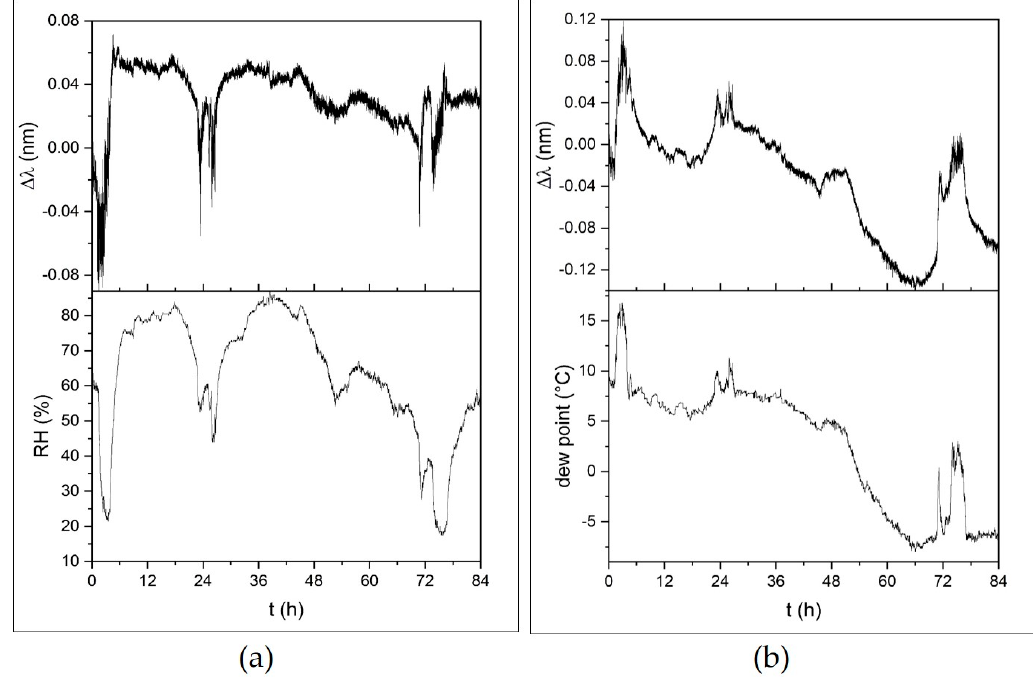
Figure 8. Response of sample FBG-PVC for three days in May: ( a ) raw signal, ( b ) temperature-compensated signal. RH and the dew point were measured by the reference thermo-hygrometer. Sample FBG-FP and sample FBG-FP-S were produced and tested in parallel. In